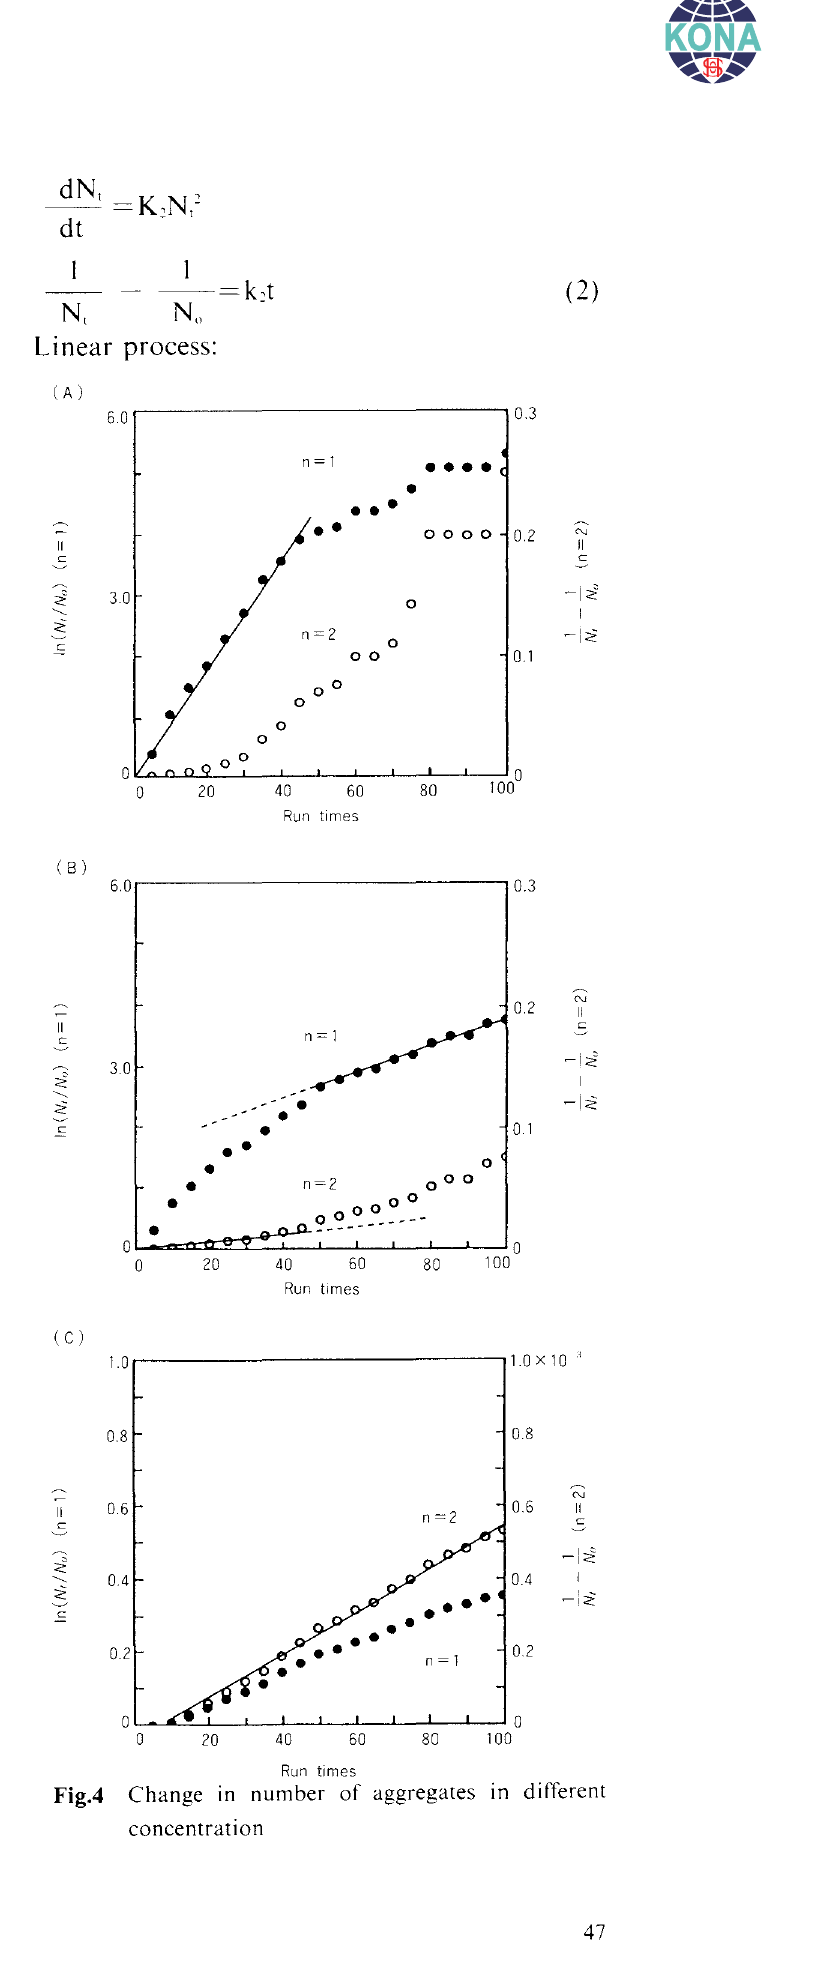
Fig.4 Change in number of aggregates in different